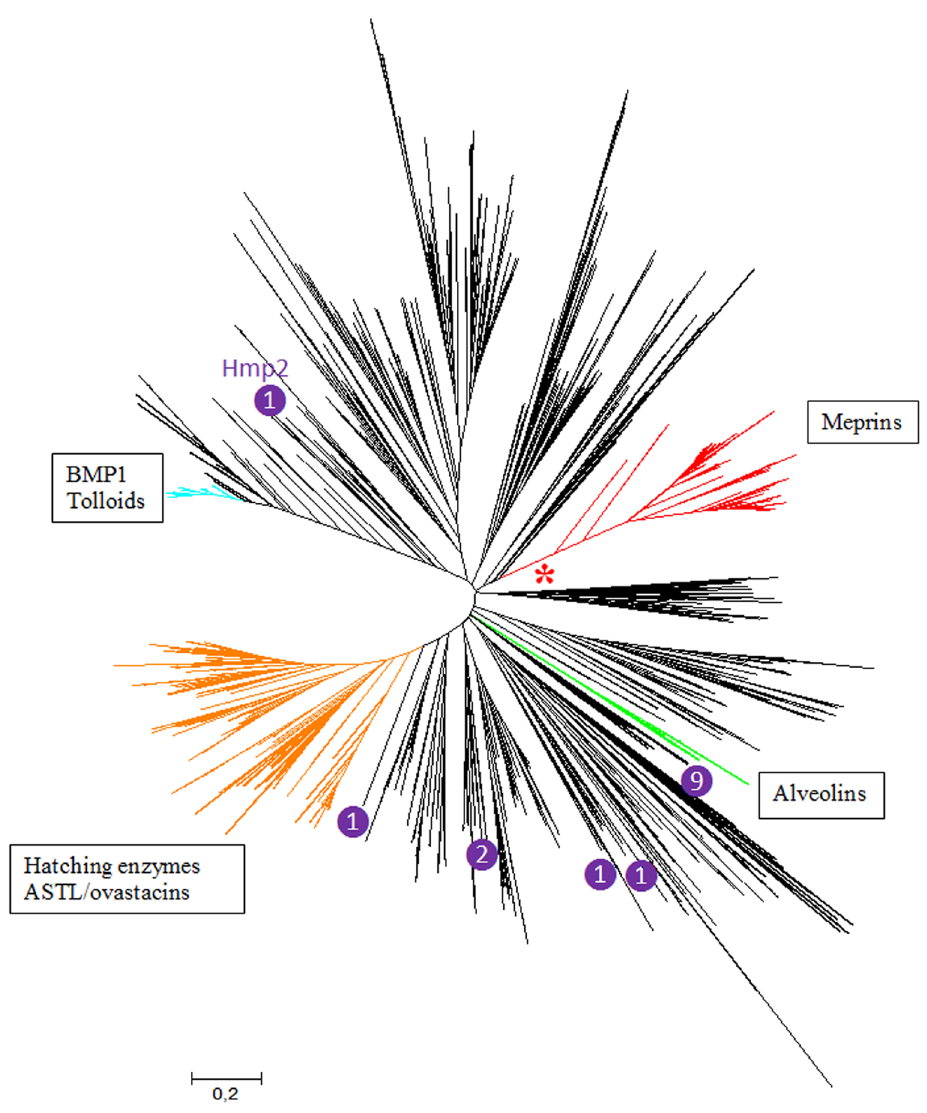
Fig 1. Maximum likelihood (ML) tree obtained with 1861 selected protease domains. The best model for this ML analysis was the WAG model of amino acidic substitutions with a gamma (G) distribution with five categories of sites, to account for heterogeneity in evolutionary rates (this is known as WAG + G model). The four main groups of vertebrate astacin metalloproteases are indicated (branches of colors other than black). An asterisk indicates the meprin branch (red) which is shown in detail in Fig 2. Numbers refer to how many astacins unrelated with meprin but containing MAM domains are in the respective positions in the tree. Hmp2 (top left) is a Hydra vulgaris protein which was proposed to be a meprin-like protease (see text), but here is shown to be just distantly related to meprins. The other MAM-containing astacins are (clockwise, starting with the largest group): nine very similar proteins found in mollusks (from the species Aplysia californica [3 sequences], Todarodes pacificus [3 sequences], Sepiella maindroni [1 sequence] and Heteroligo bleekeri [2 sequences]); two proteins of the scorpion Tityus serrulatus , which appear close, but, as it can be seen, slightly separated in the tree; two very similar proteins of the cephalochordate Branchiostoma floridae ; and, finally, a single protein of the urochordate Ciona intestinalis